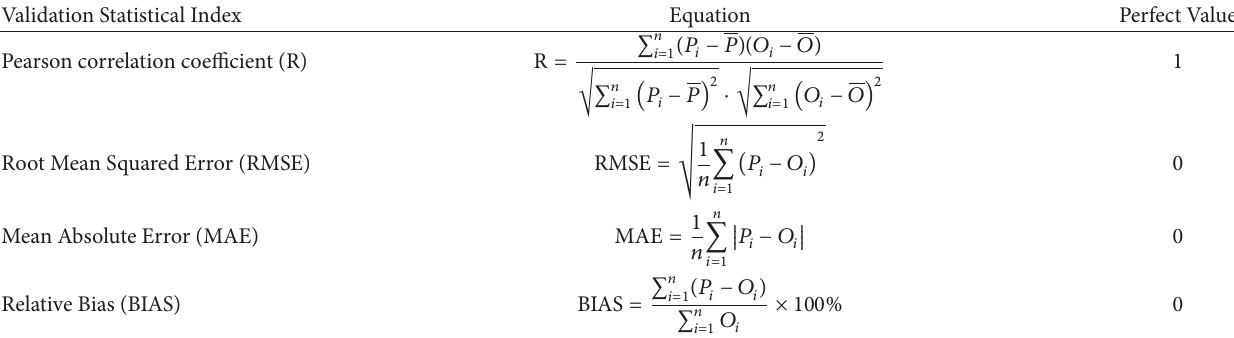
Table 1: List of the statistical indices for validation used to compare for-profit real estate information website housing prices with the official